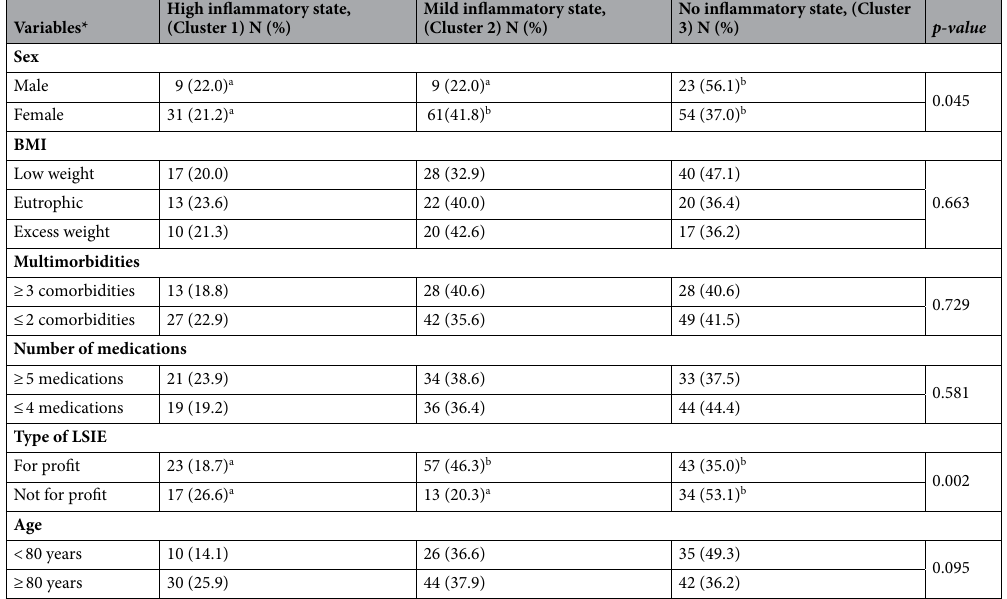
Table 3. Association of inflammatory states with sex, age, BMI, morbidities, polypharmacy, and type of LSIE of institutionalized older people. BMI body mass index, LSIE long-term institution for the older people. a/b Different letters denote a statistically significant difference between the clusters.